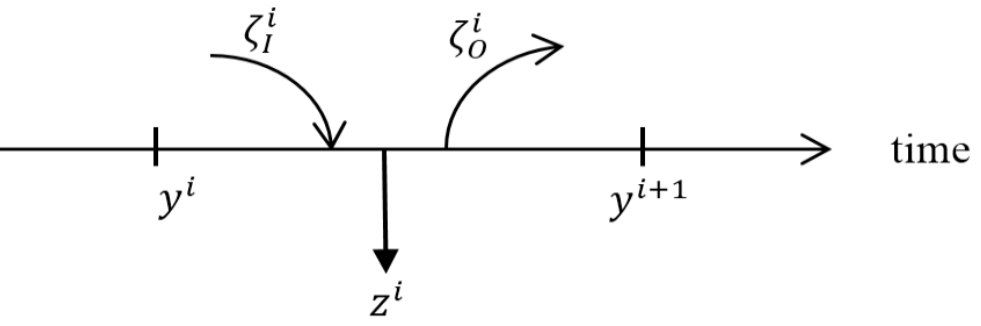
Figure 1. Flow of Figure 1. Flow of goods.